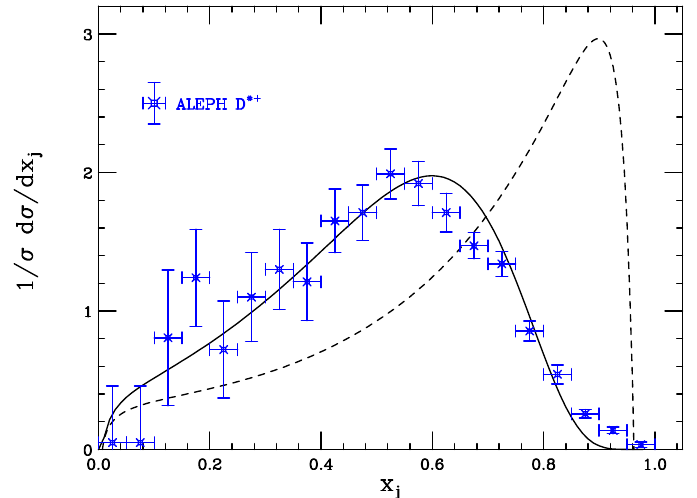
Figure 4. Experimental data on D ∗ + production at ALEPH, compared with a calculation in the NLO+(N)NLL approximation, as in [21], using an effective coupling constant (solid) and µ 0 F = 2 m c and m c = 1.8 GeV in the computation, with the other parameters set to the values described in the text. The dashed line corresponds to a parton-level prediction using the standard strong coupling constant and the same set of perturbative parameters.